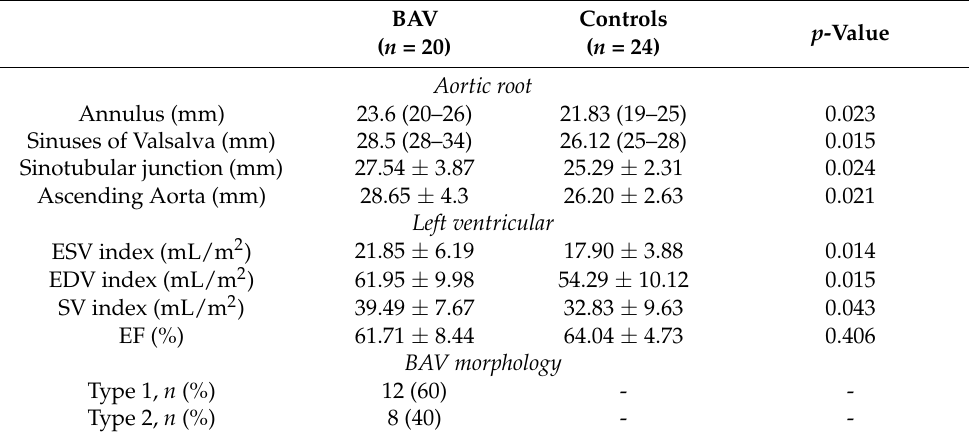
Table 2. Echocardiographic measurements of aortic root dimensions and left ventricular